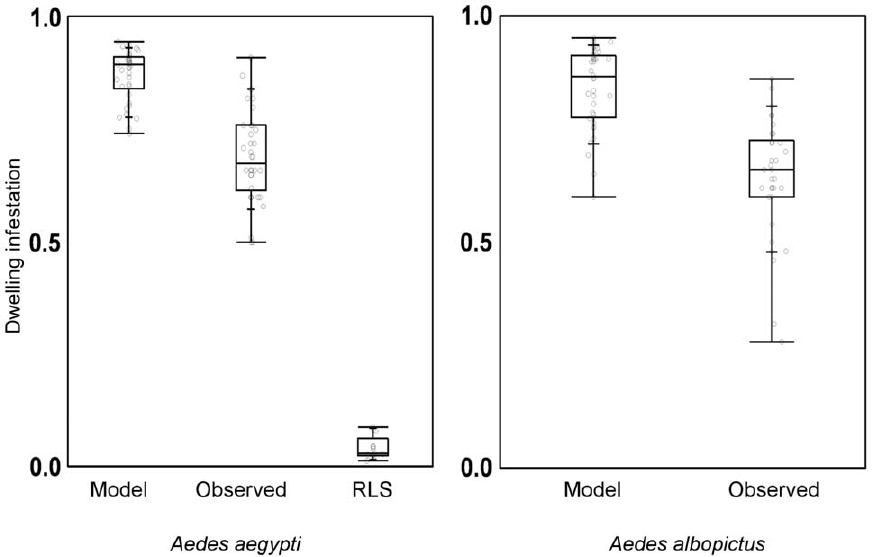
Figure 4. Bias in Aedesaegypti (left) and Ae.albopictus (right) observed infestation. Model-derived point estimates (‘‘Model’’) correspond to the top-ranking, 38-month dynamic model for each species; observed dwelling infestation recorded during our surveys (‘‘Observed’’) and indices of dwelling infestation by Ae. aegypti reported by the regular vector surveillance system, derived from ‘rapid larval surveys’ [28] (‘‘RLS’’). Monthly values (empty circles) and quartiles 50% (horizontal line within box), 25%–75% (box lower-upper limits), 10%–90% (short lines), and 0%–100% (bottom-top lines) are shown. All values are presented as proportions.